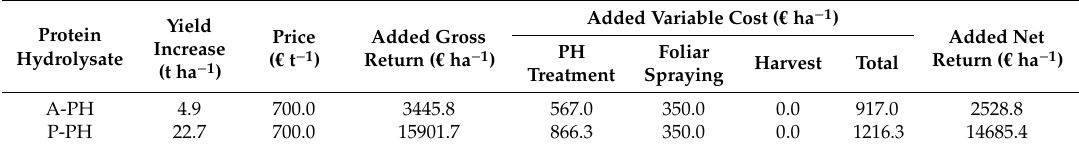
Table 6. Added returns acquired by animal-derived protein hydrolysates (A-PH) and plant-derived protein hydrolysates (P-PH) under tunnel conditions compared to the untreated control. Protein